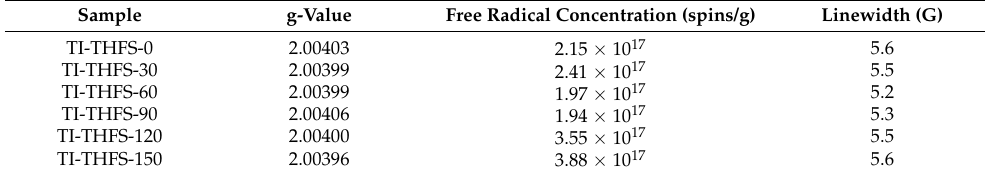
Table 6. Free radical concentration, g-value, and linewidth of the TI-THFS fraction.